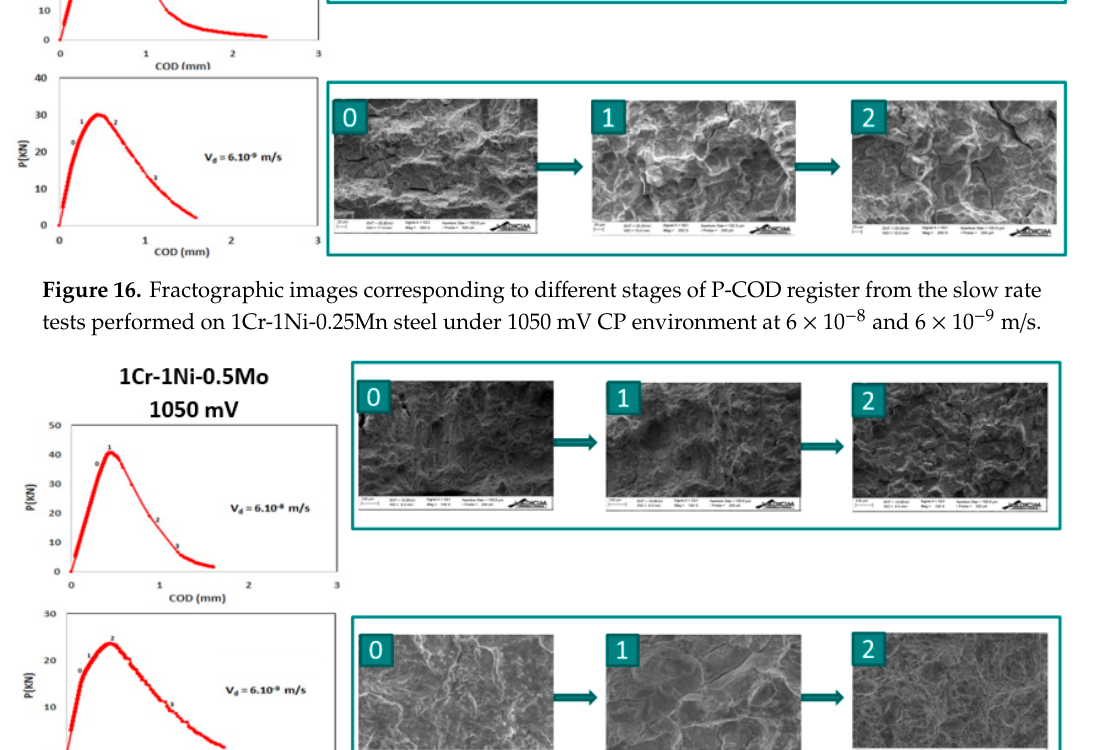
Figure 17. Fractographic images corresponding to different stages of P-COD register from the slow rate tests performed on 1Cr-1Ni-0.5Mo steel under 1050 mV CP environment at 6 × 10 − 8 and 6 × 10 − 9 m/s.